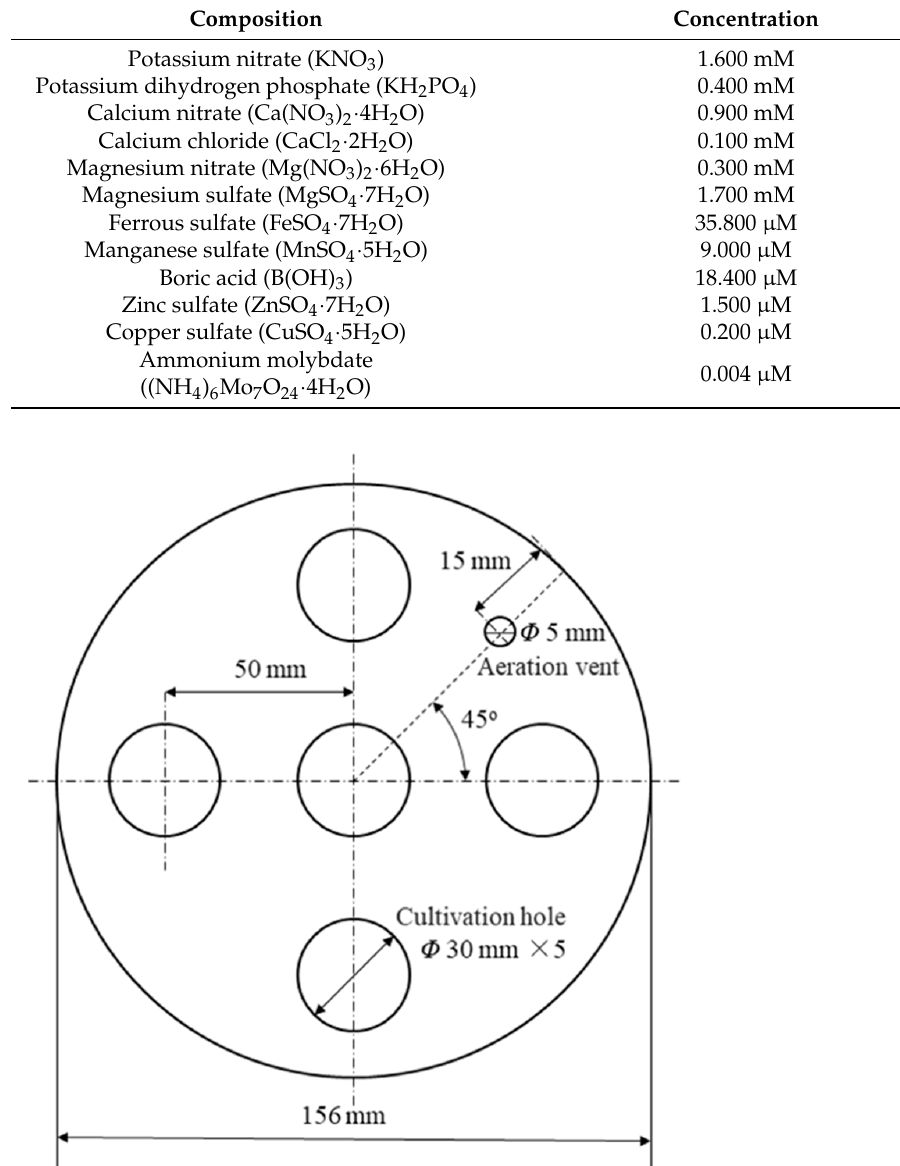
Figure 2. The hydroponic cultivation experiment used in this study.